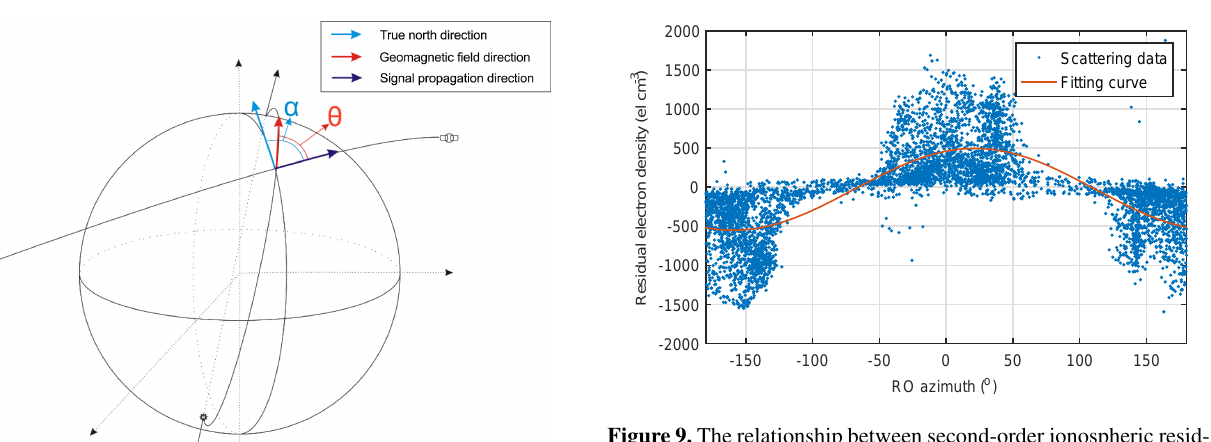
Figure 9. The relationship between second-order ionospheric resid- ual electron density and RO azimuth.